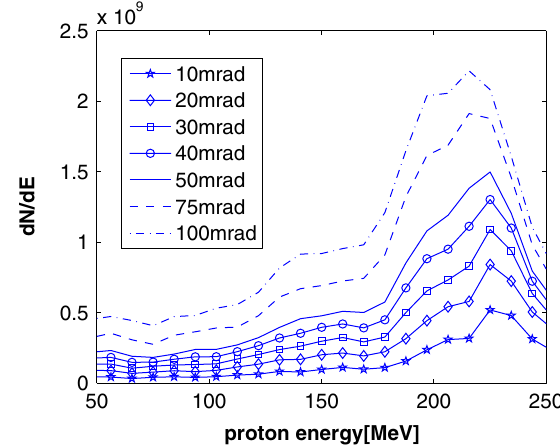
FIG. 5. Spectral yield of protons as a function of energy and for different production cone